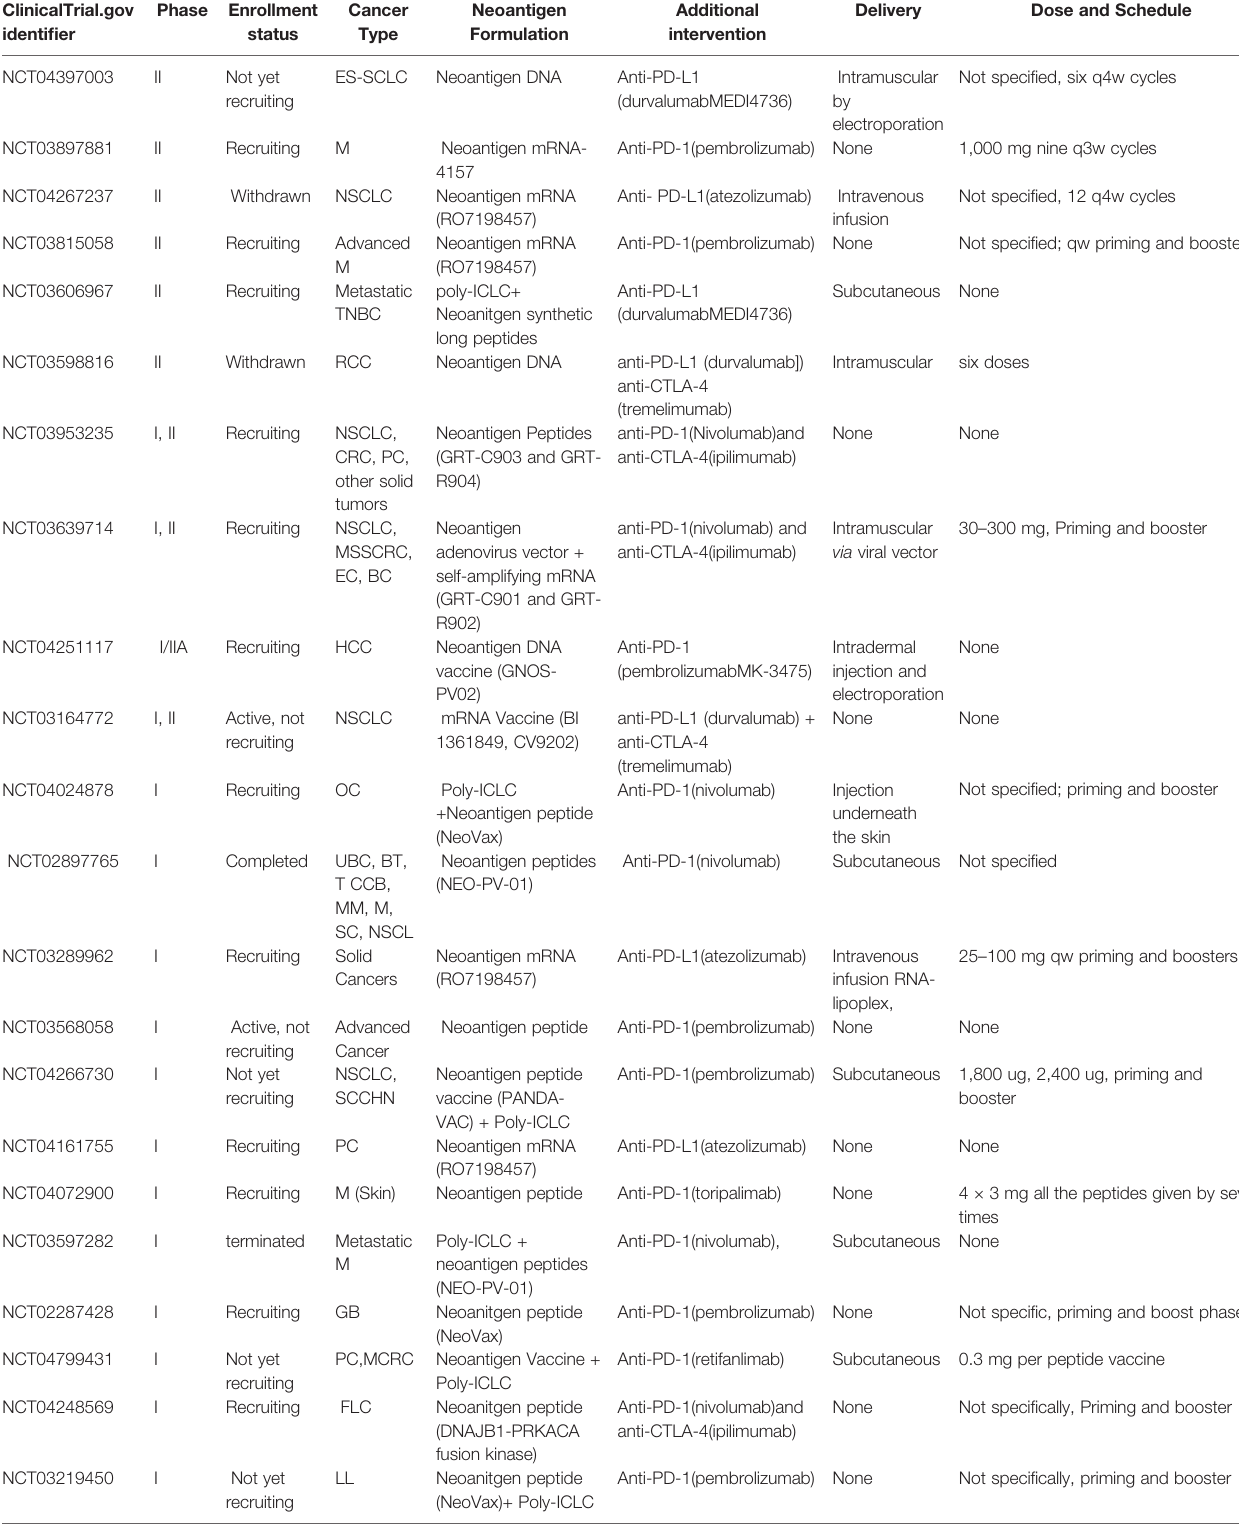
TABLE 2 | Recent clinical trials combining neoantigen vaccines with immune checkpoint inhibitors. ClinicalTrial.gov identi fi